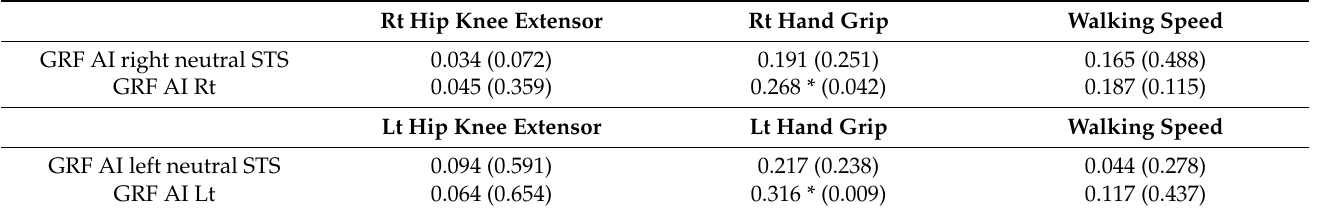
Table 4. Concurrent validity analysis of force plate (r, Pearson correlation) ( n =